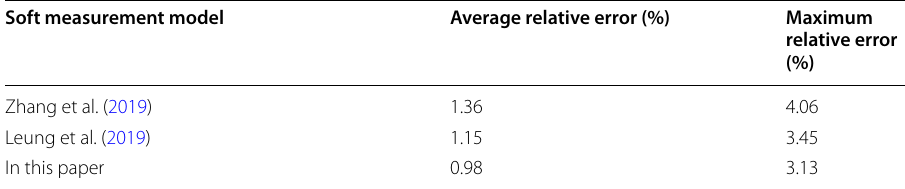
Table 7 Relative errors comparison with different soft measurement values Soft measurement model Average relative error (%)